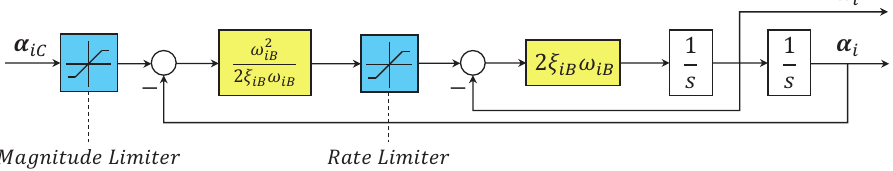
Figure 3. Framework of the command filter, with ω iB and ξ iB being design constants, i ∈ Σ